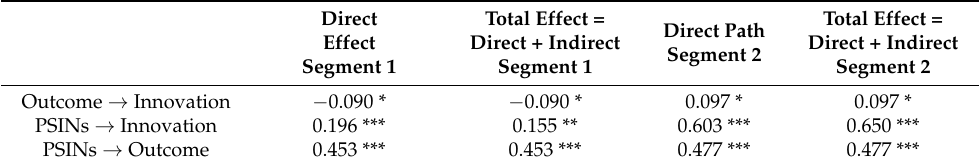
Table 2. Indirect effects on the paths in the unobserved